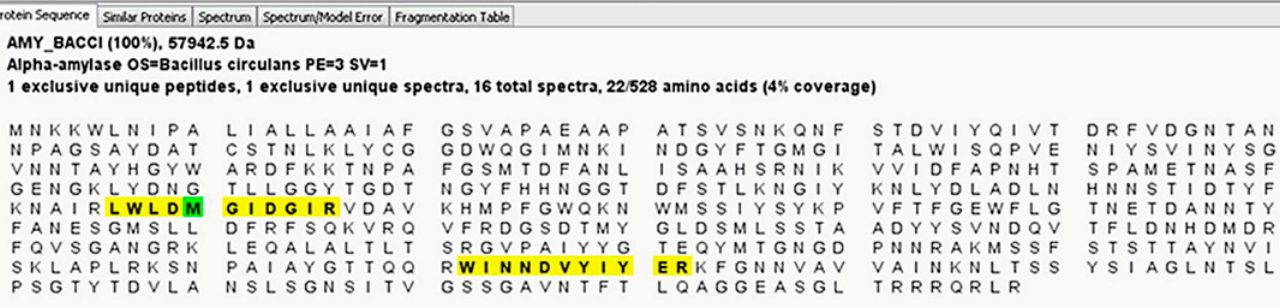
Figure 4. Identification of alpha-amylase in aroma from liquefied pudding. Sequence coverage of alpha-amylase from Bacillus circulans (detected peptides are highlighted in yellow, amino acids with post-translational modifications are shown in green) from a representative mass spectrometry run. Sequence coverage of AMY_BACCI was 4%.